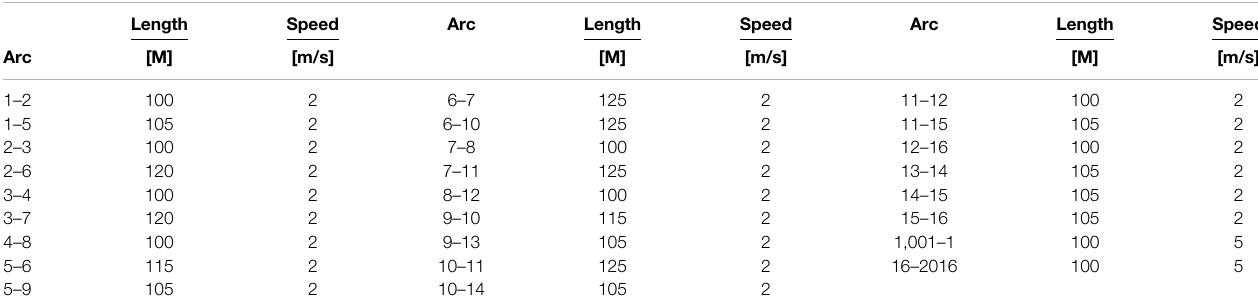
TABLE 2 | Characteristics of the arcs of the test